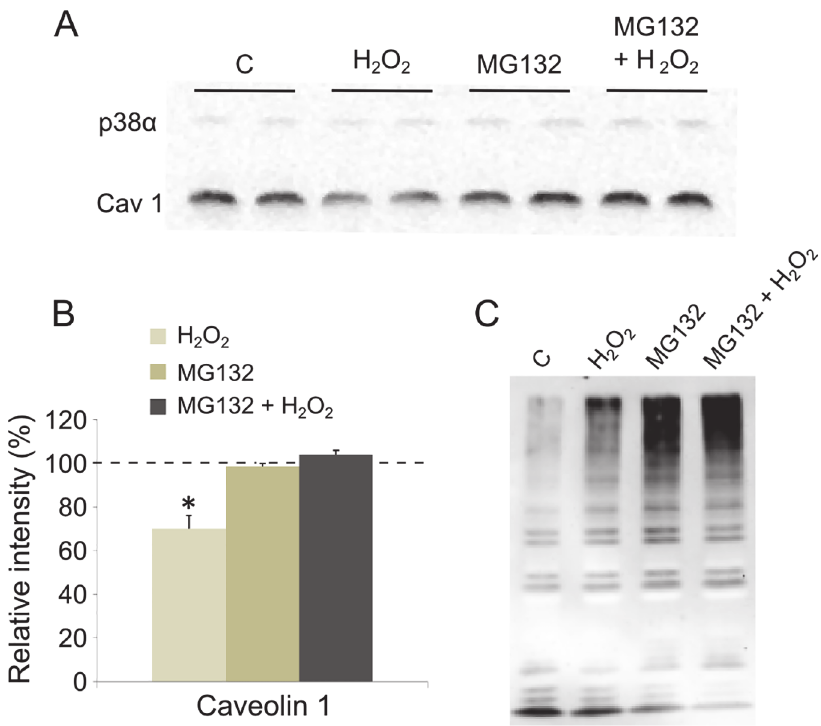
Fig 2. Effect of MG132 on H 2 O 2 -induced caveolin 1 decrease. Cells were pre-incubated for 3 h with MG132 (50 μ M) before addition of 500 μ M H 2 O 2 . After 10 minutes, cells were collected and protein extracts (15 μ g) were loaded onto SDS-PAGE. Immunodetection was carried out using specific antibodies for caveolin 1 (cav1) and p38 α , which was used as a loading control (A). The level of caveolin 1 was quantified and expressed as a percentage of the level obtained in the untreated control cells ( — -) (B). Immunodetection was also carried out to monitor polyubiquitinylated protein accumulation using anti-ubiquitin antibodies (C). C: control. Bars on the graph represent the SEM. * Significantly different from the control ( P < 0.05).